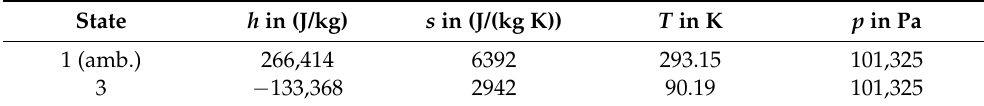
Table 3. State variables for oxygen